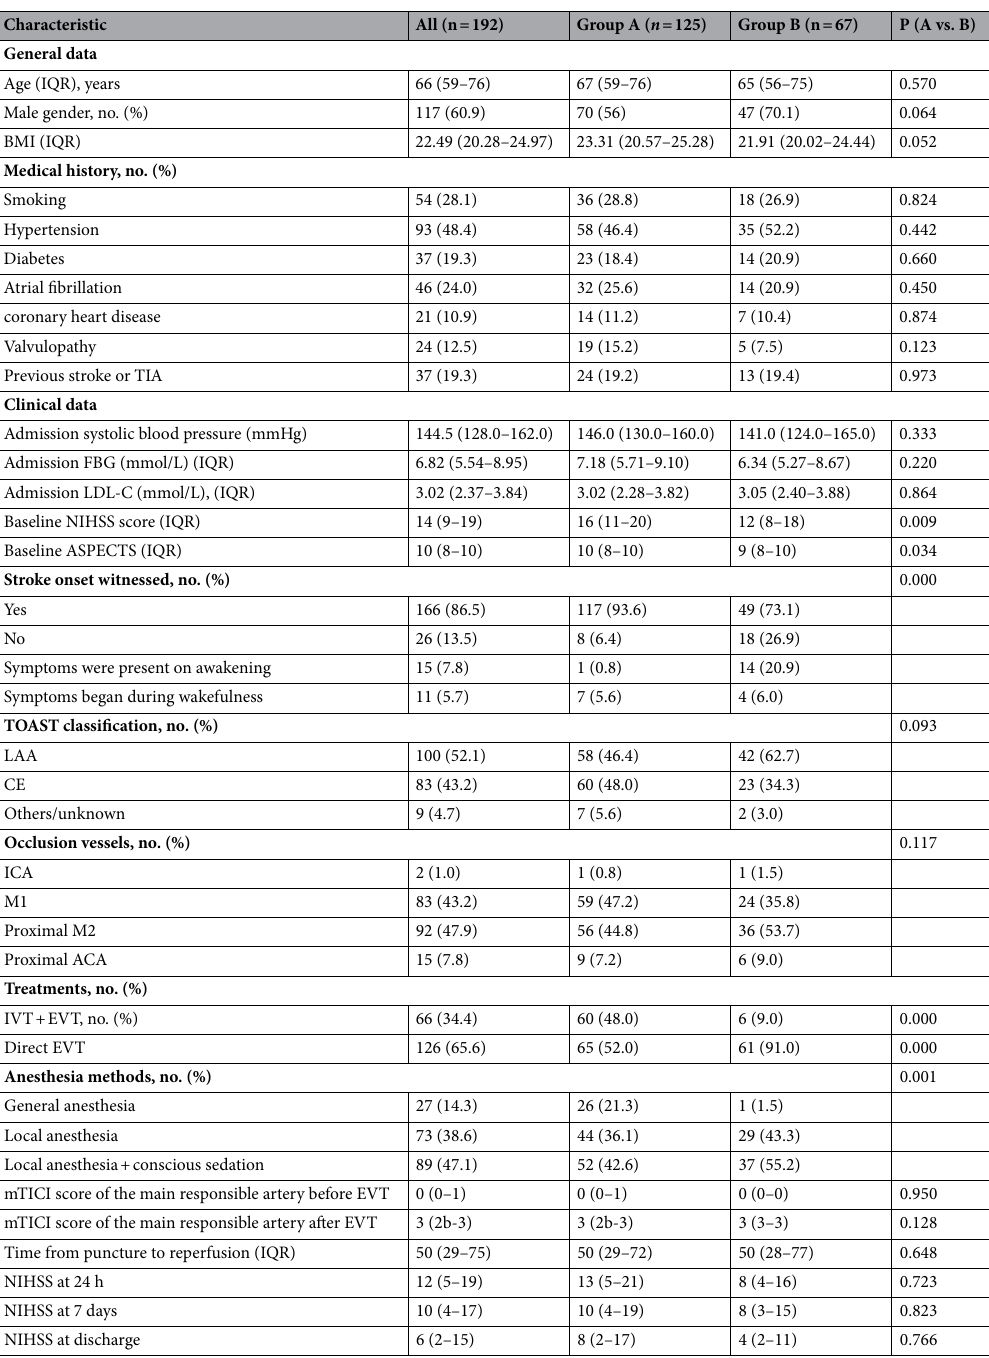
Table 1. Baseline characteristics of patients and features of EVT. Three data missing in group A of anesthesia method. IQR interquartile range, BMI body mass index, FBG fasting blood-glucose, LDL-C low density lipoprotein cholesterin, TIA transient ischemic attack, NIHSS National Institutes of Health Stroke Scale score, mRS modified Rankin Scale, ASPECTS Alberta Stroke Program Early CT Score, LAA large artery atherosclerosis, CE cardiogenic, ICA internal carotid artery, M1 the first section of medial cerebral artery, M2 the second section of medial cerebral artery, ACA anterior cerebral artery, IVT intravenous thrombolysis, EVT endovascular